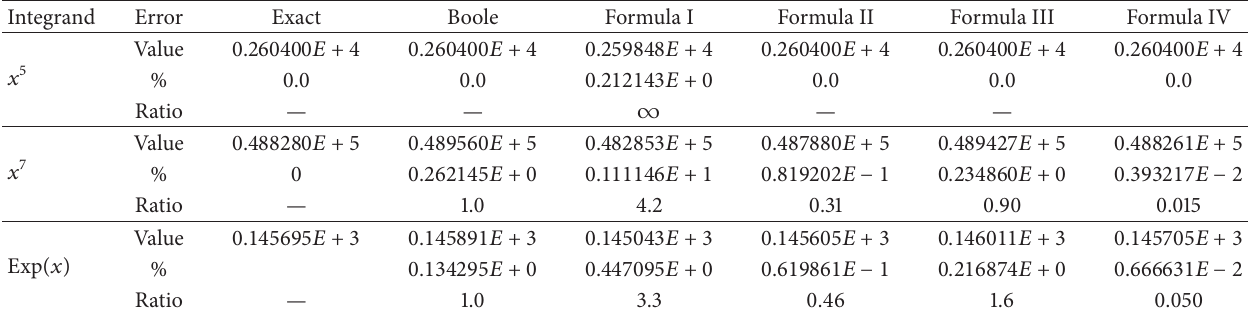
Table 8: Comparison of the integrals using four formulae of extrapolation methods (end-point Gauss quadrature) with Boole’s rule.